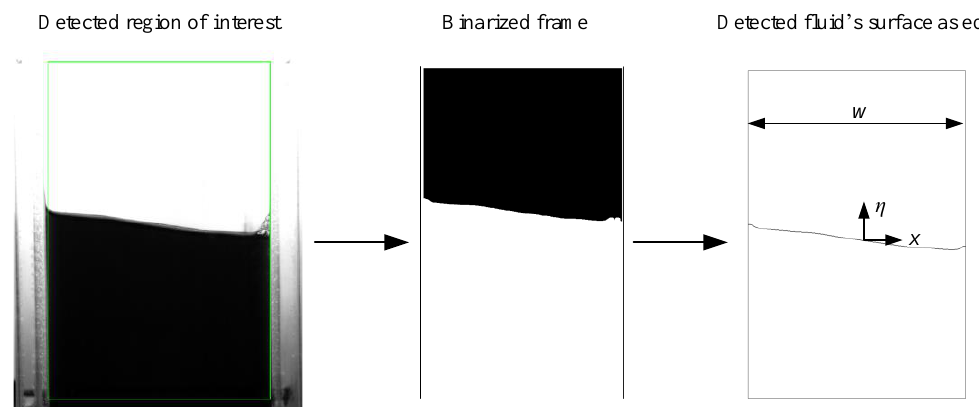
Figure 3. Steps in detecting the fluid’s surface edge for the container’s width w : first, the region of interest is detected; second, the frame is binarized by setting a threshold value; third, the edge is detected by the C ANNY algorithm. The ( x , η ) -values of the edge are saved.